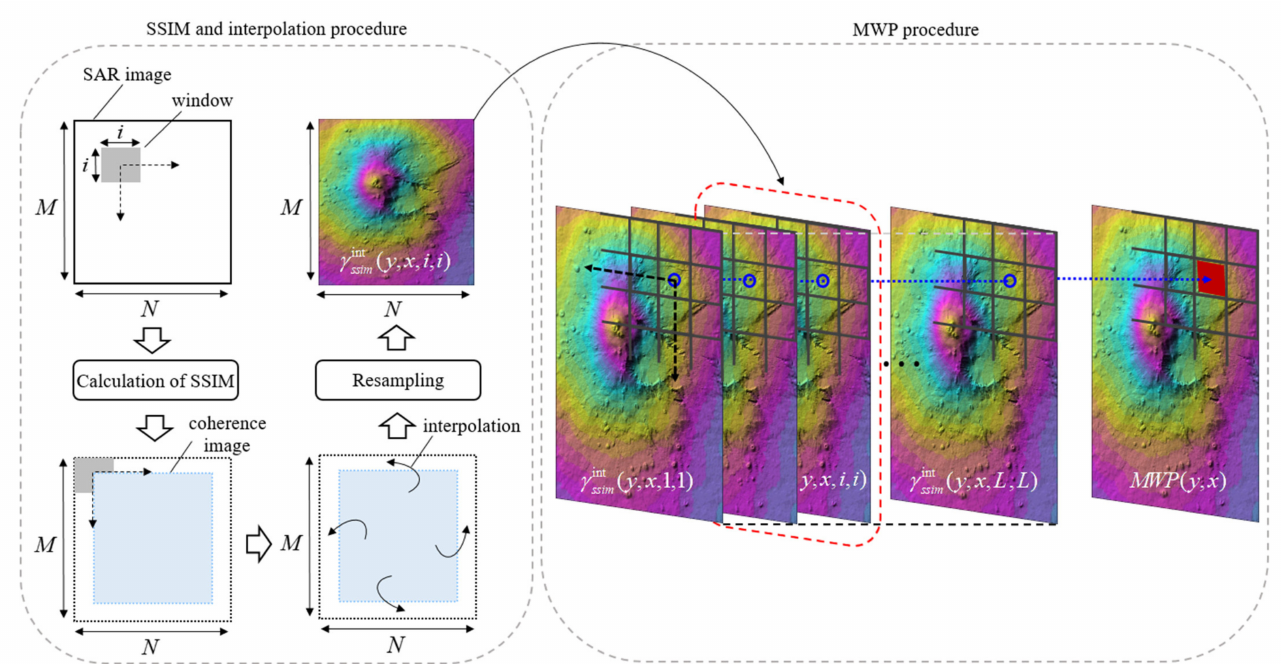
Figure 1. Schematic diagram of the SSIM and MWP